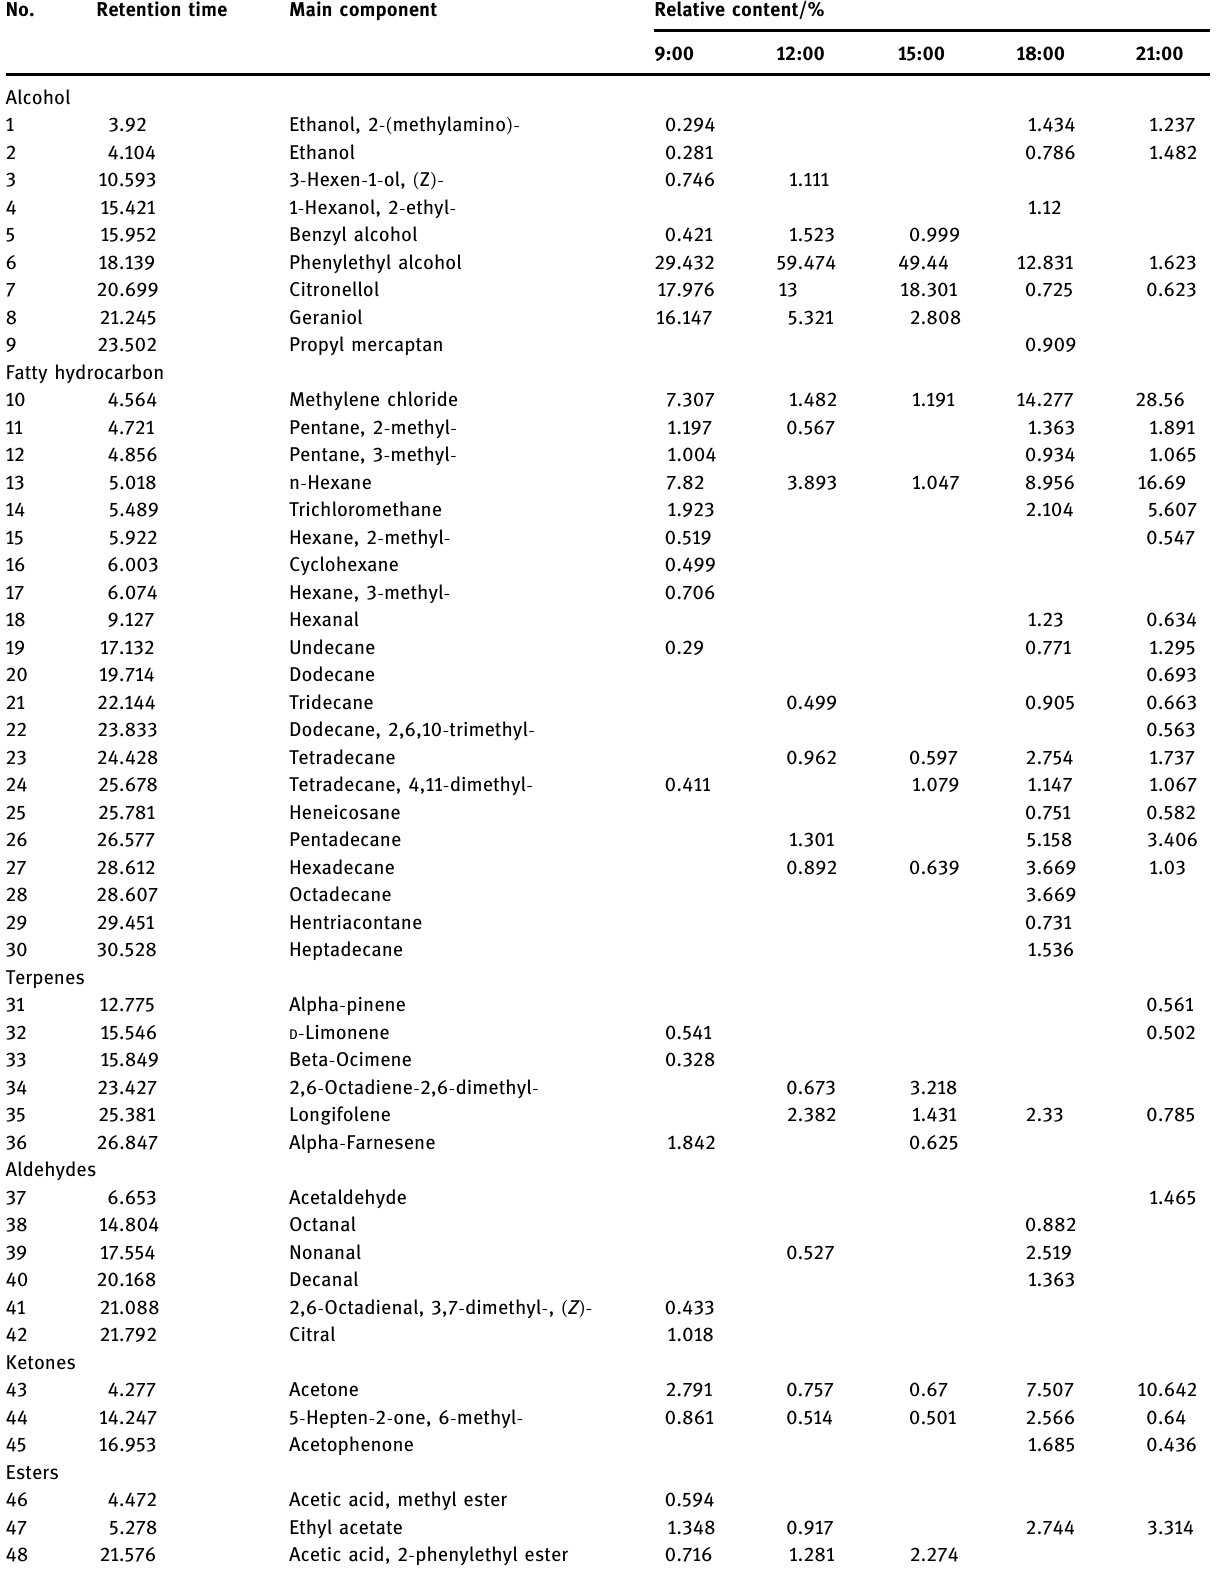
Table 1: Analysis result of fl oral composition and relative content of rose